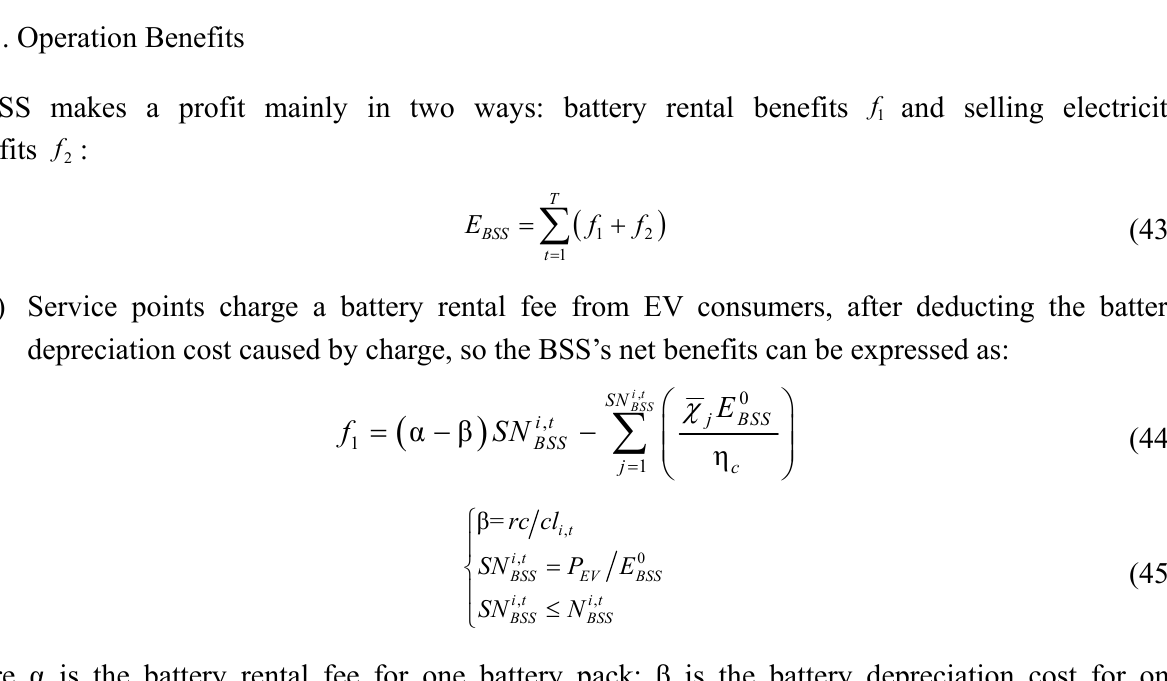
Figure 2. Schematic diagram of a battery switch